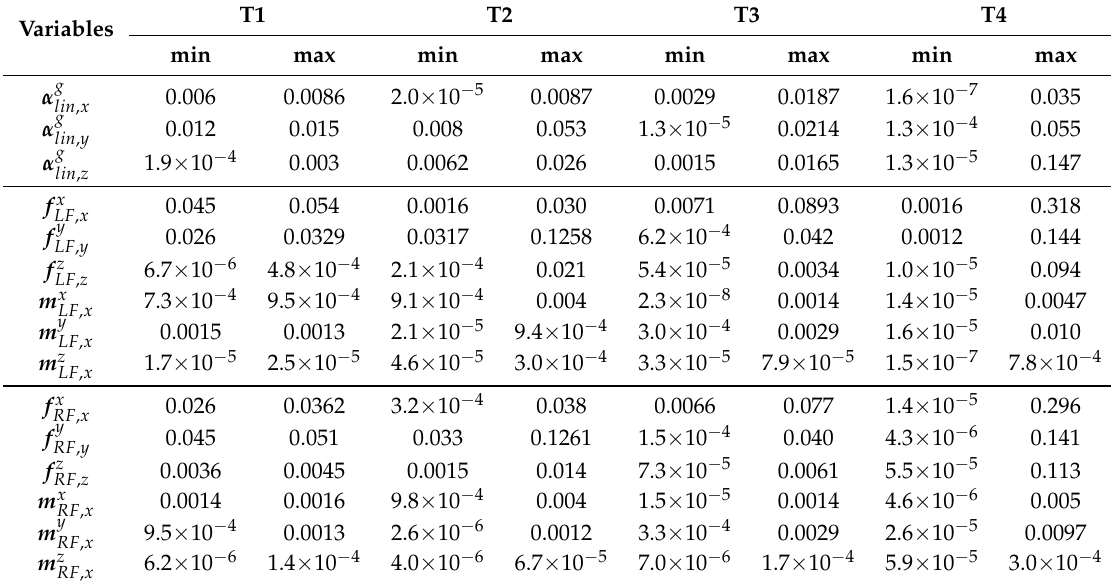
Figure 9. Norm of the overall error of the entire set of joint accelerations ε ( ¨ s ) [ rad/s 2 ] between measurement and estimation via floating-base MAP algorithm, for tasks T1, T2, T3 and T4. Table 3. Max and min values for RMSE analysis in Table 2, for tasks T1, T2, T3 and